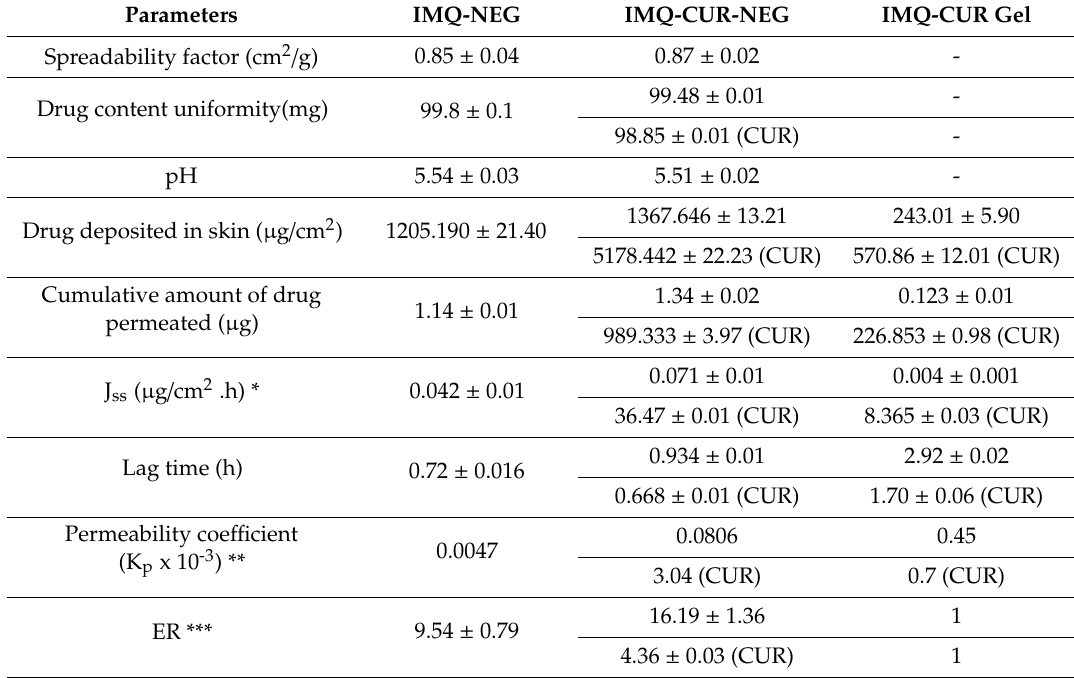
Table 3. Characterization of di ff erent gel formulations (IMQ-NEG, IMQ-CUR-NEG, and IMQ-CUR gel). Parameters IMQ-NEG Spreadability factor (cm 2 / g) Drug content uniformity(mg)